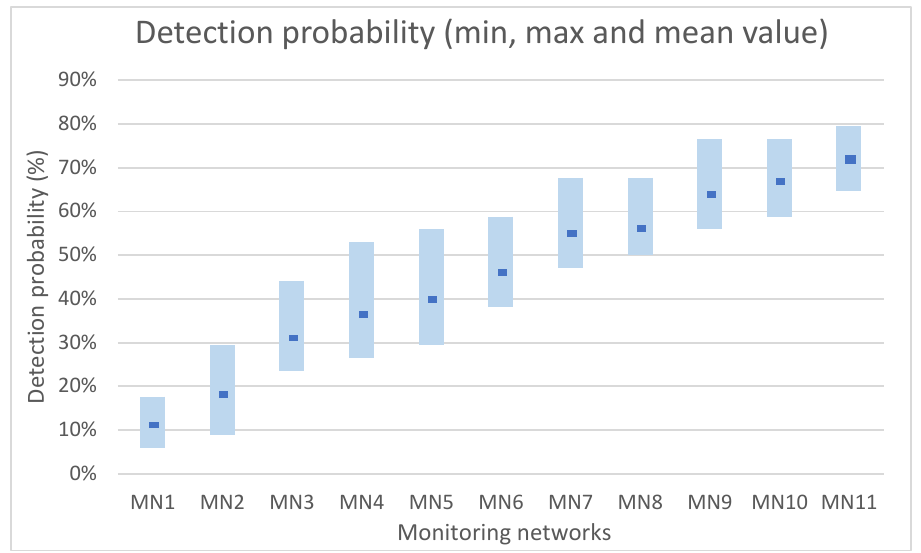
Figure 3. Detection probability minimum, maximum and mean values for monitoring networks (consisting of nodes for installation of sensors based on Ο 2 objective).